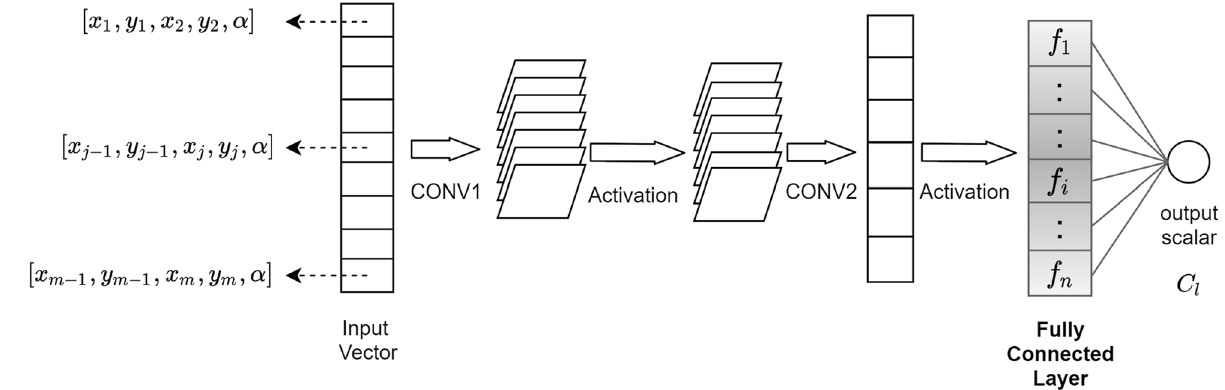
Figure 1. ESCNN architecture.